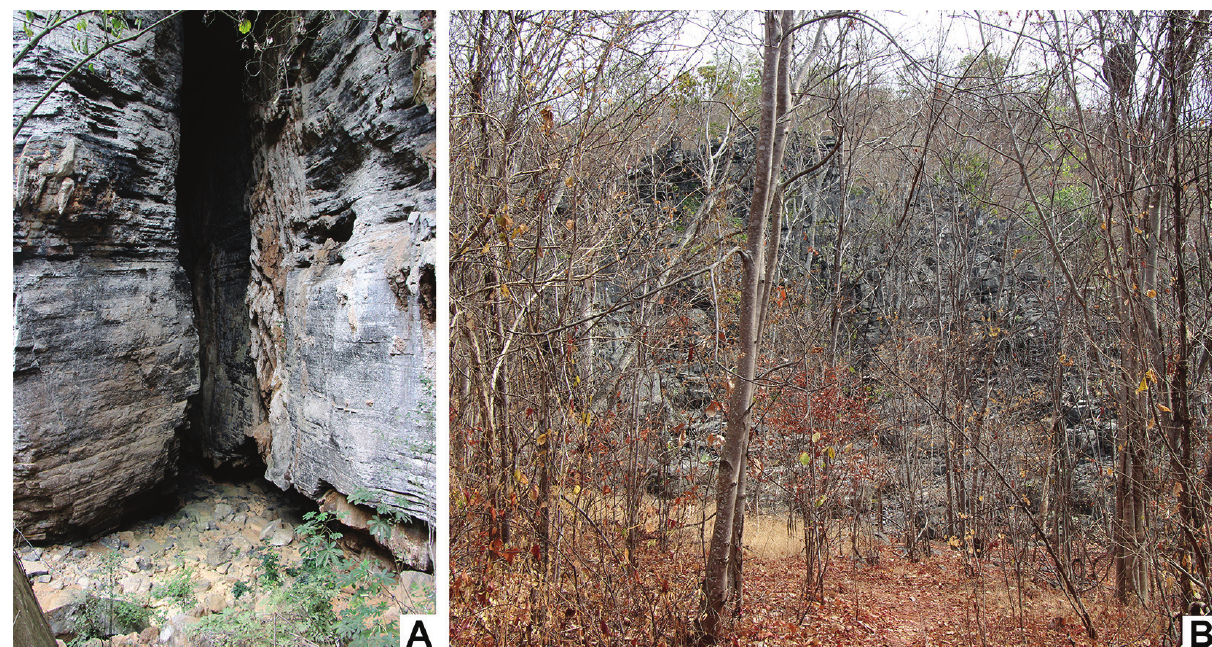
Figure 1. Lapa do Cipó cave, Peruaçu Caves National Park, state of Minas Gerais, Brazil. A, cave entrance; B, surrouding